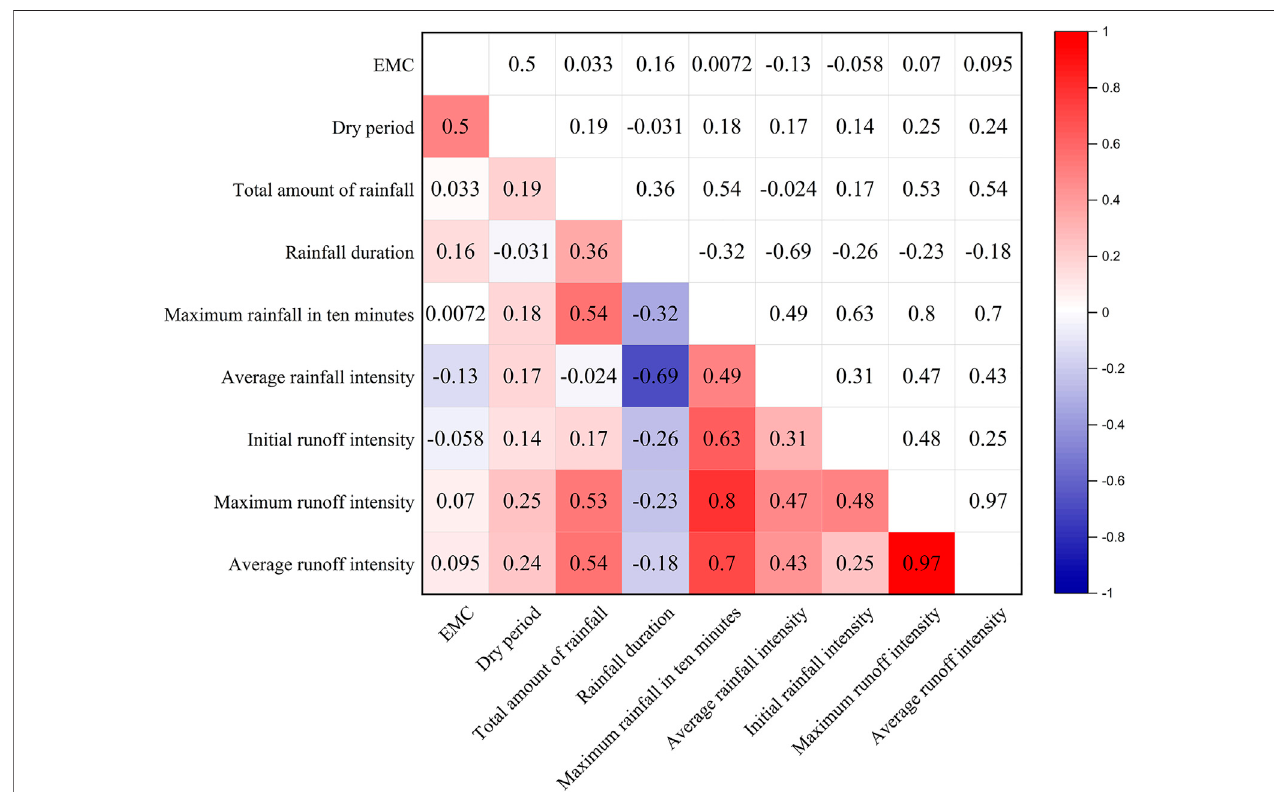
FIGURE5| CorrelationsbetweenrainfallcharacteristicsandEMC.Redandbluesquaresrepresentpositiveandnegativecorrelationsbetweentwocharacteristics, respectively. Deeper color indicates a stronger correlation.